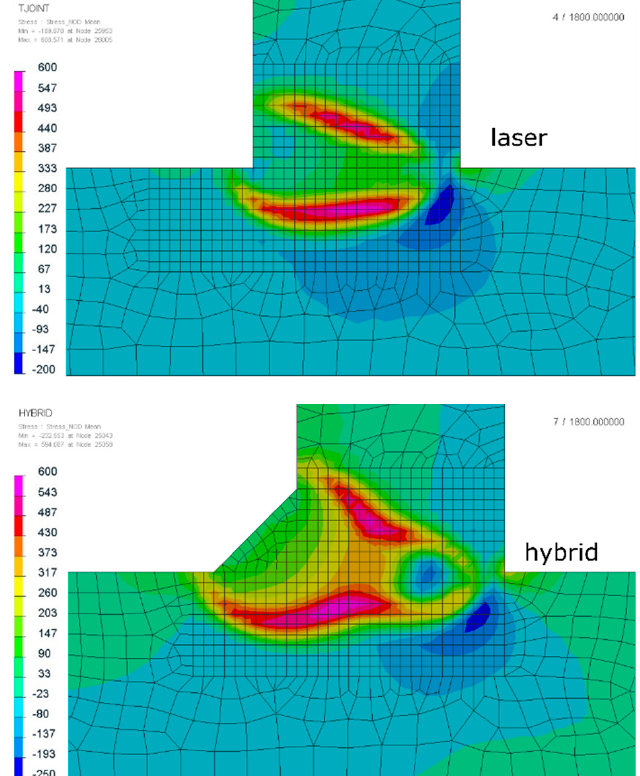
Figure 11. Residual stress distributions of laser and hybrid welded S700MC steel T-joints with a thickness of 10 mm (cross-sections were made in the half-length of the joint).